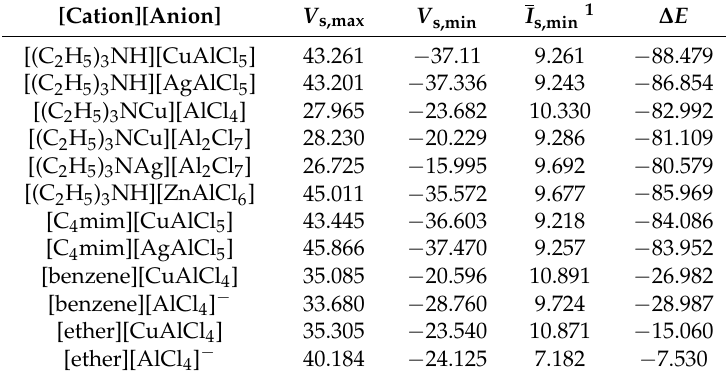
Table 2. Cation-anion interaction energies and the surface parameters of the ILs